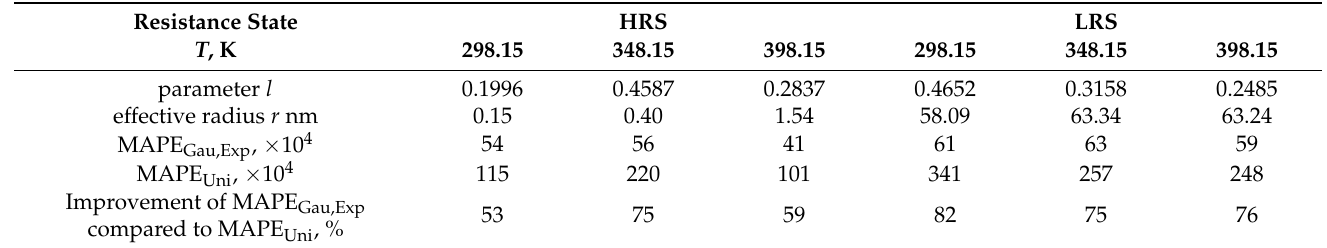
Table 1. Values of calculated parameters for I Gau , Exp and comparison of approximation accuracy with I Uni